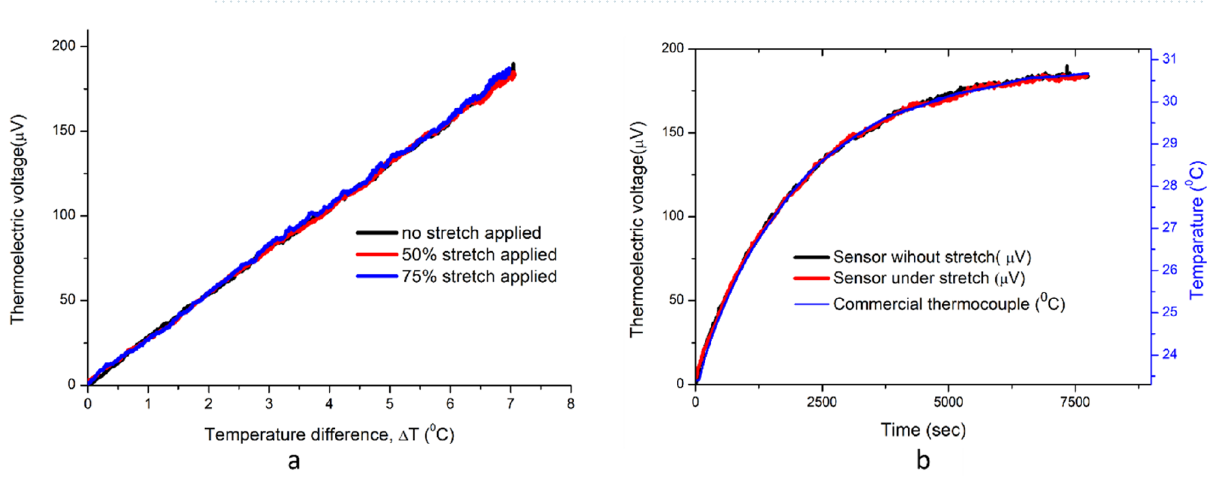
Figure 7. The temperature sensing using proposed sensor at different strain conditions ( a ) Temperature rise at the hot junction over time monitored with the sensor in unstretched and stretched (50% strain) conditions. Simultaneously, the hot junction temperature measurement with a commercial thermocouple ( b